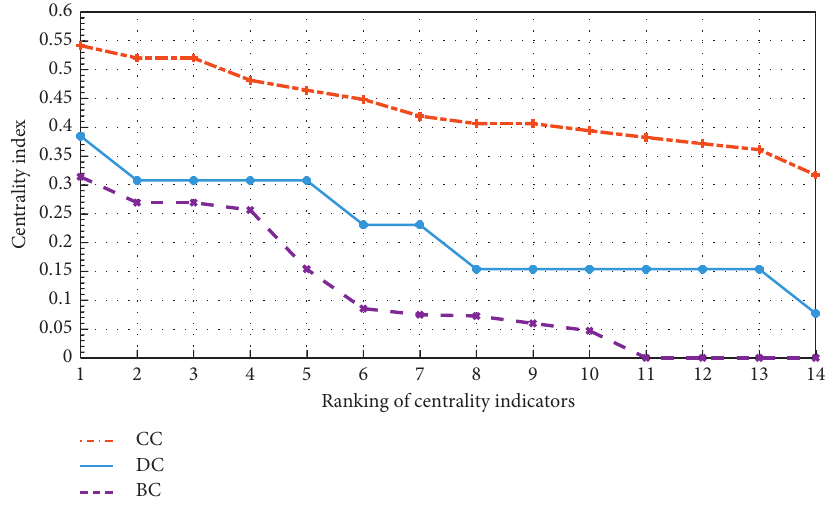
Figure 3: Central index descending order of the IEEE14